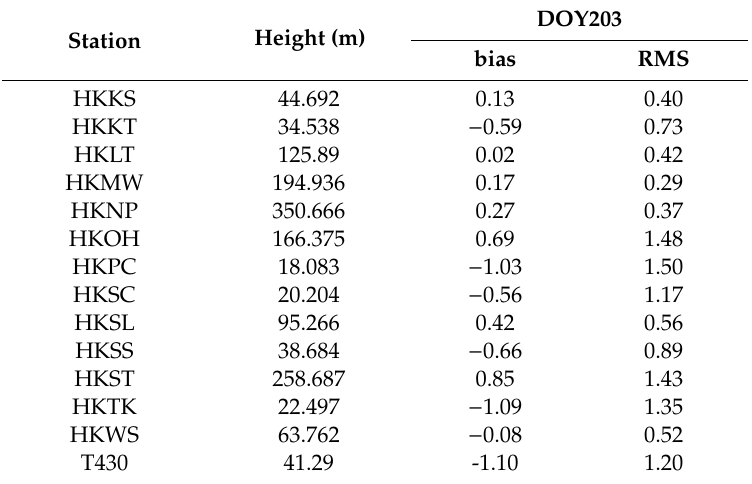
Table 6. Precision of the local troposphere fusion model for each station on